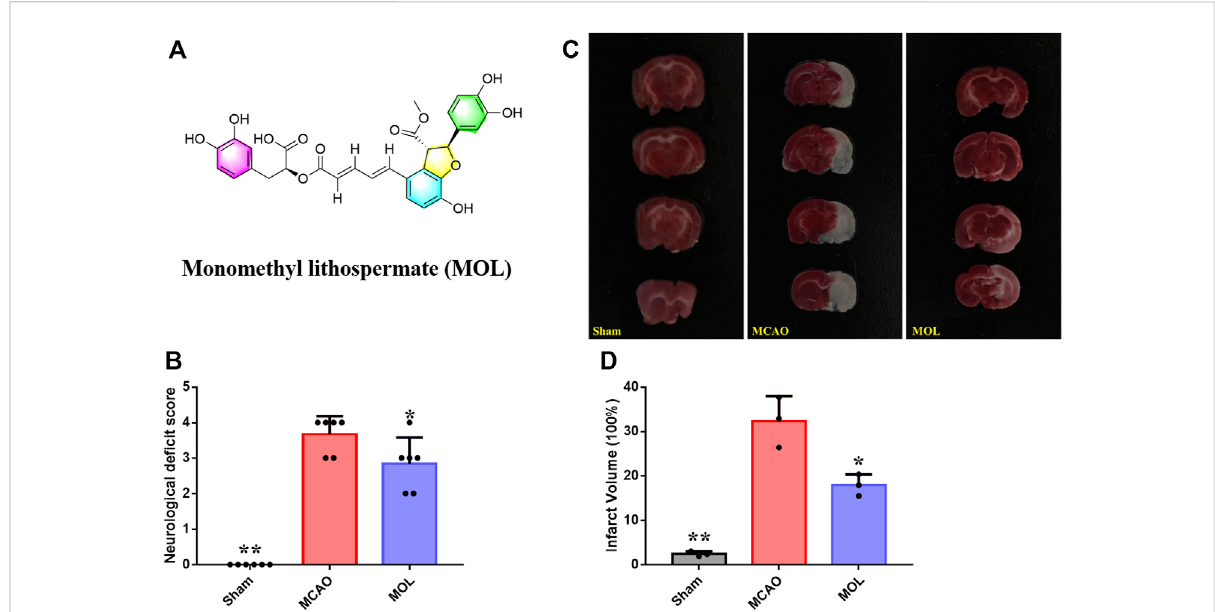
FIGURE 1 MOL can improve the neurological function of MCAO rats and reduce the area of cerebral infarction. (A) Chemical structure of MOL; (B) Improvetheneurologicalde fi citscoreofMCAOrats; (C) EffectofMOLoninfarctsizeinMCAOrats; (D) StatisticsofcerebralinfarctsizeinMCAOrats. Data expressed as Mean ± SD, ** p < 0.01, * p < 0.05 vs. MCAO